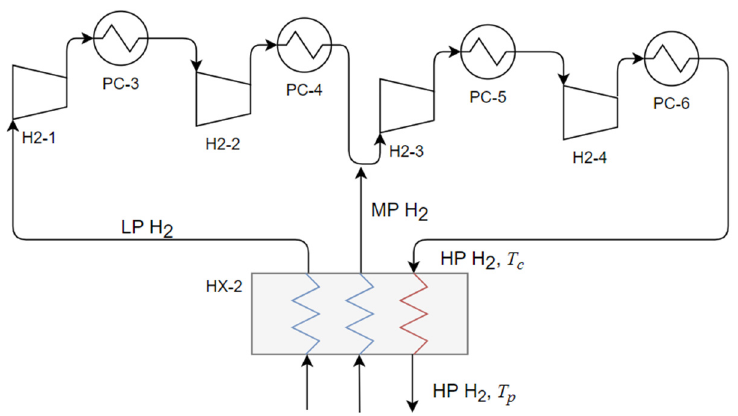
Figure 2. Flow diagram of the cryogenic-cooling step H 2 cycle compressor.